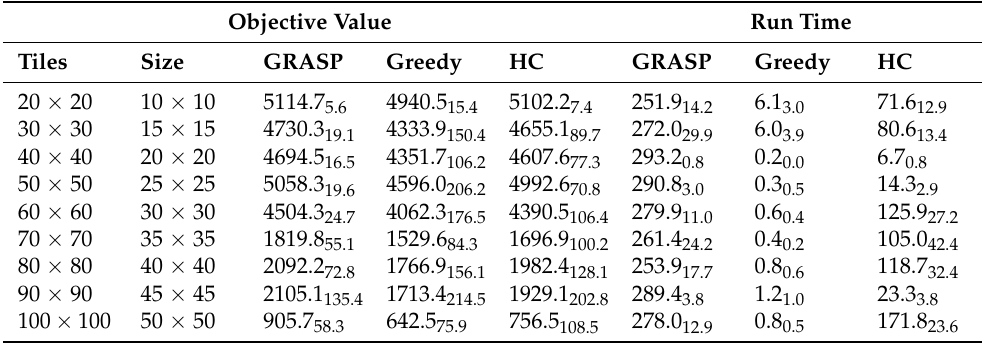
Table A1. Values represent the objective values and runtime respectively, and the subscripts represent the standard deviations. The sizes are expressed in